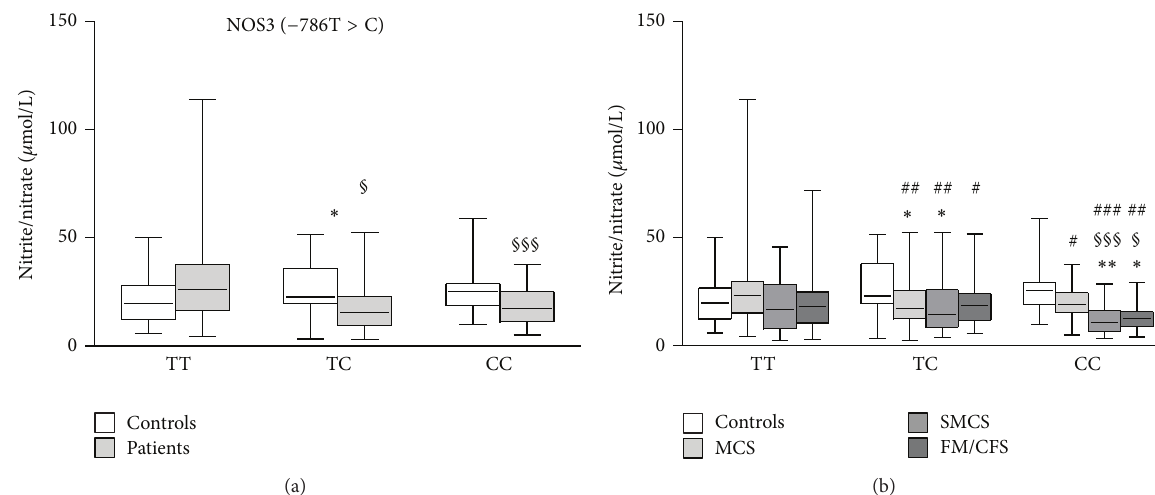
Figure 2: Effects of different NOS3 − 786T > C genotypes on nitrite/nitrate plasma levels in IEI patients (MCS = 170; SMCS = 108; FM/CFS = 89), grouped together (a) or separated (b), and controls ( 𝑁 = 196 ). Box-plots graphically depict the variation in plasma nitrite/nitrate concentrations of patients and healthy subjects, having different NOS3 − 786T > C genotypes, through their quartiles. The bottom and top of the boxes are the first and third quartiles, and the band inside the boxes is the second quartile (the median); lines extending vertically from the boxes (whiskers) indicate variability outside the upper and lower quartiles (the ends of the whiskers represent the minimum and maximum of all of the data). (a) ∗ 𝑃 < 0.05 , significant difference in comparison with controls; § 𝑃 < 0.05 , §§§ 𝑃 < 0.001 , significant difference in comparison with TT patients. (b) ∗ 𝑃 < 0.05 , ∗∗ 𝑃 < 0.01 significant difference in comparison with controls; § 𝑃 < 0.05 , §§§ 𝑃 < 0.001 significant difference in comparison with TC controls; # 𝑃 < 0.05 , ## 𝑃 < 0.01 , ### 𝑃 < 0.001 significant difference in comparison with TT